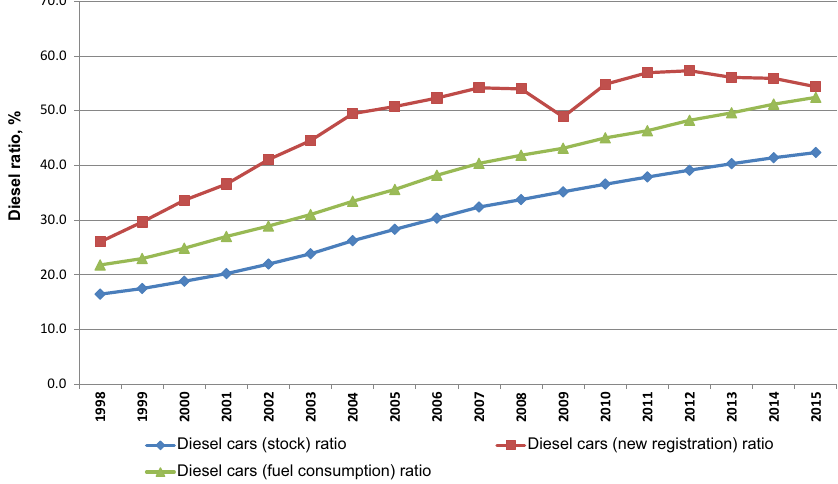
Fig.1 DieselizationinmainWesternEUcountriesdieselcars(stock),newregistrationandfuelconsumption with respect to the total 5.05.56.06.57.07.58.08.5